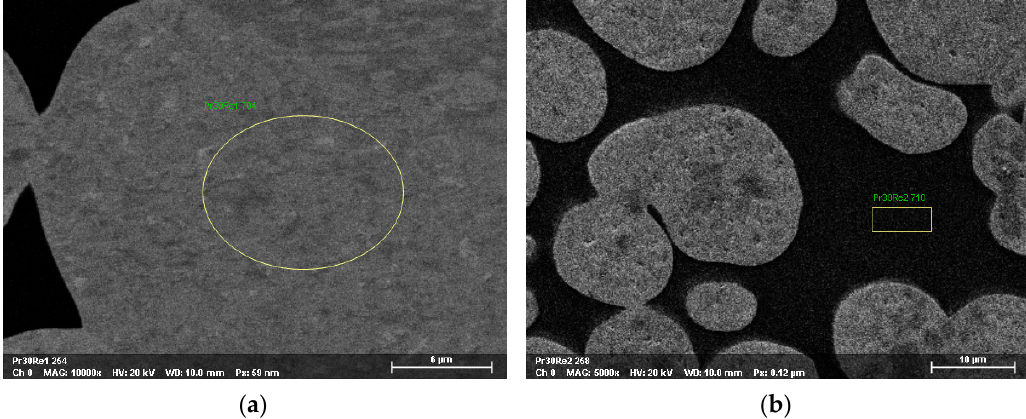
Figure 7. SEM micrograph with marked places of EDS analysis in the area of tungsten grains ( a ) and matrix ( b ).